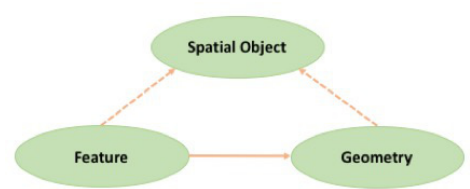
Figure 2. GeoSPARQL ontology